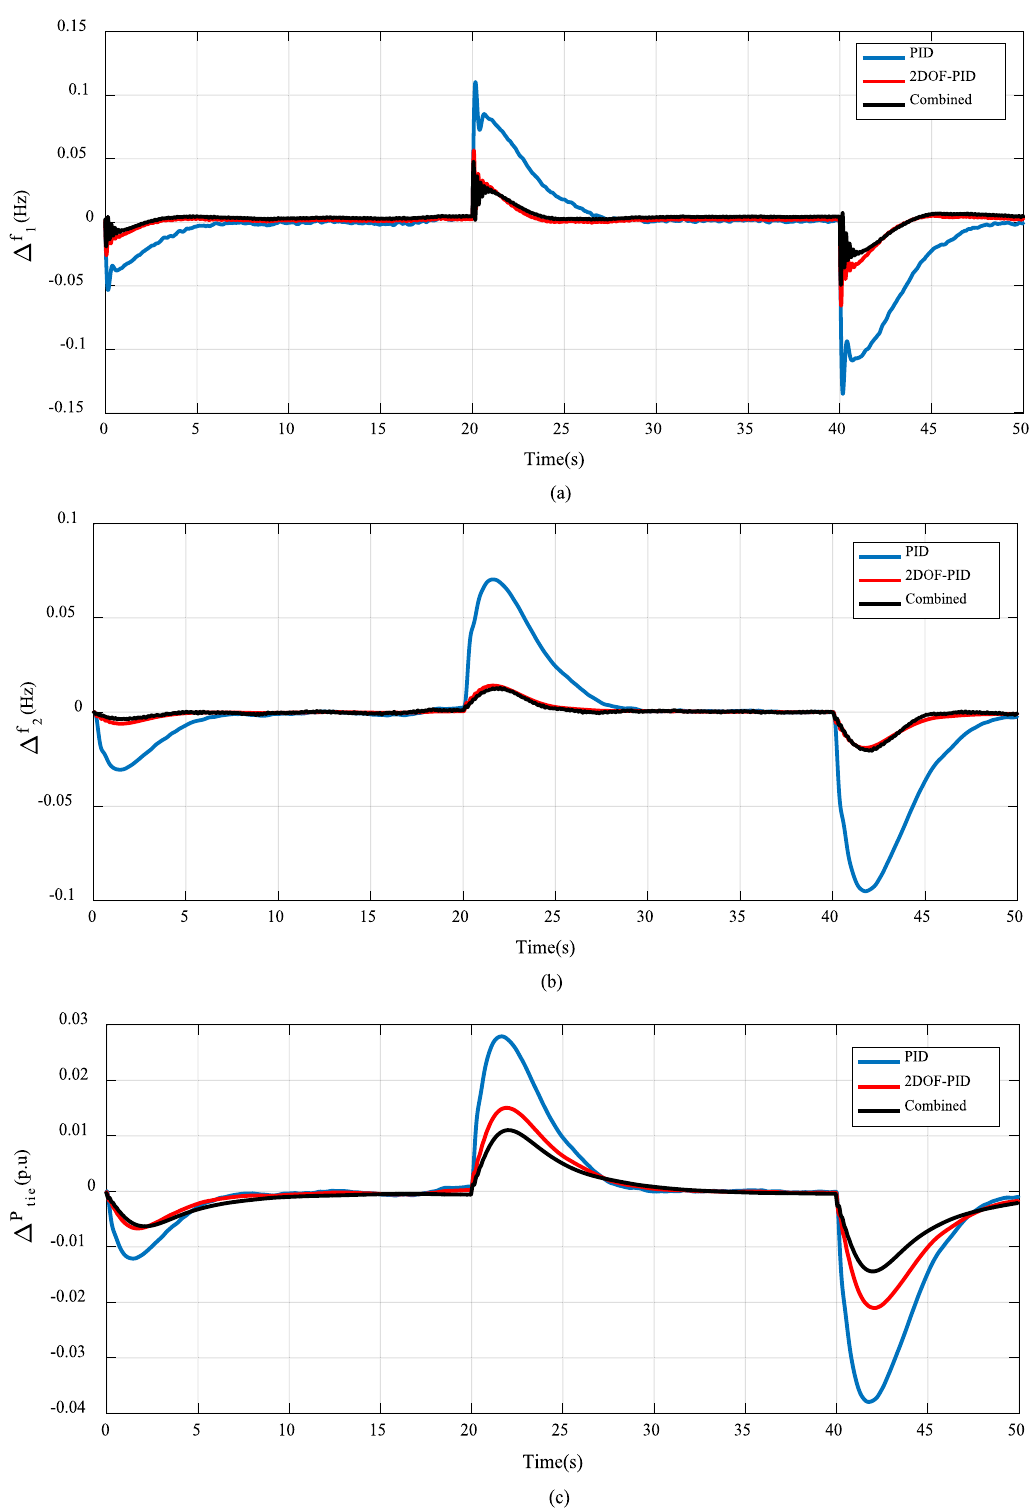
Fig. 9 Improvement in responses with the combined controller during simultaneous changes of load (as shown in Fig. 10), wind disturbances. ( 3% at 20 s and 6% at 40 s). a Area I frequency change; b area II frequency change; c tie line power + −